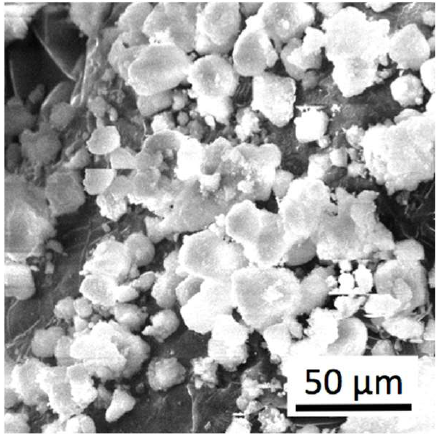
Figure 2. SEM image of ZrO 2 —5 wt.% Y 2 O 3 nanopowder.